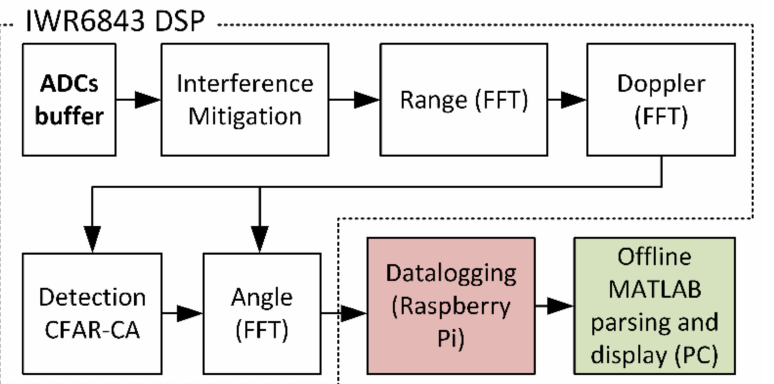
Figure 7. Software and digital signal processing chain block diagram. The four receivers’ intermediate frequency (IF) output is digitized by four analog to digital converters (ADCs) and then filtered to reduce interference. The signals are then processed by a chain of FFTs to find range, elevation and azimuth angles and, finally, they are converted to a point cloud by a CFAR-CA block. These data are then serially passed on to the datalogger and then parsed, post-processed and displayed in MATLAB. The Raspberry Pi also runs an Apache Server with PHP for command and data